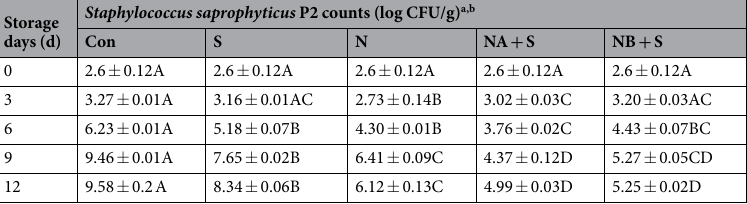
Table 1. The total viable counts in the samples treated with different antibacterial substances during storage. a Values are averages ± standard deviations. Different uppercase letters in a row indicate significant difference (p < 0.05). b Con: control sample, no SlpB/nisin added; S: SlpB 40 μ g/g; N: nisin 0.5 mg/g; NA + S: nisin 0.5 mg/g plus SlpB 40 μ g/g; NB + S: nisin 0.25 mg/g plus SlpB 40 μ